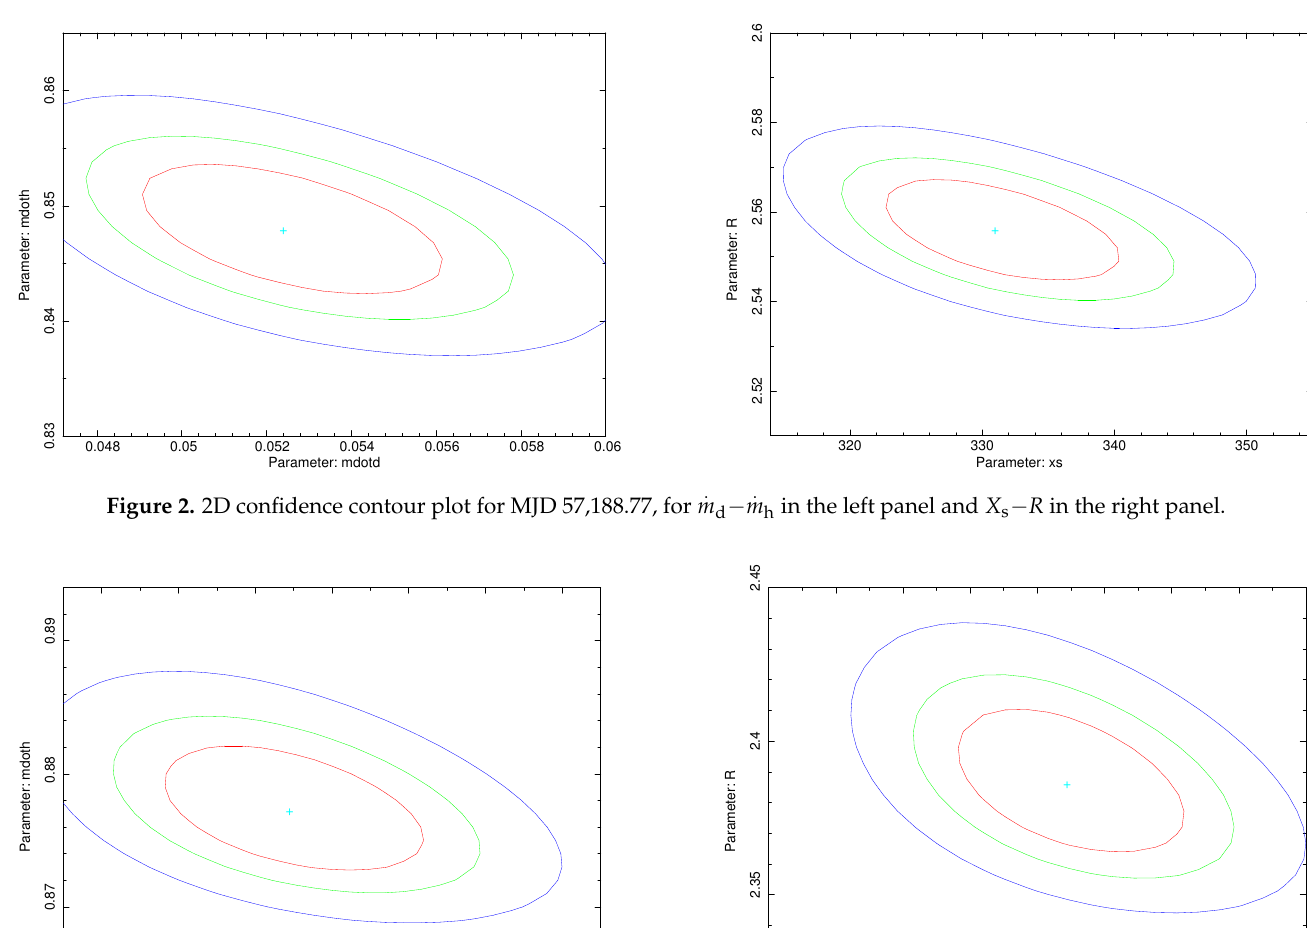
. . m d m h in the left panel and X s −